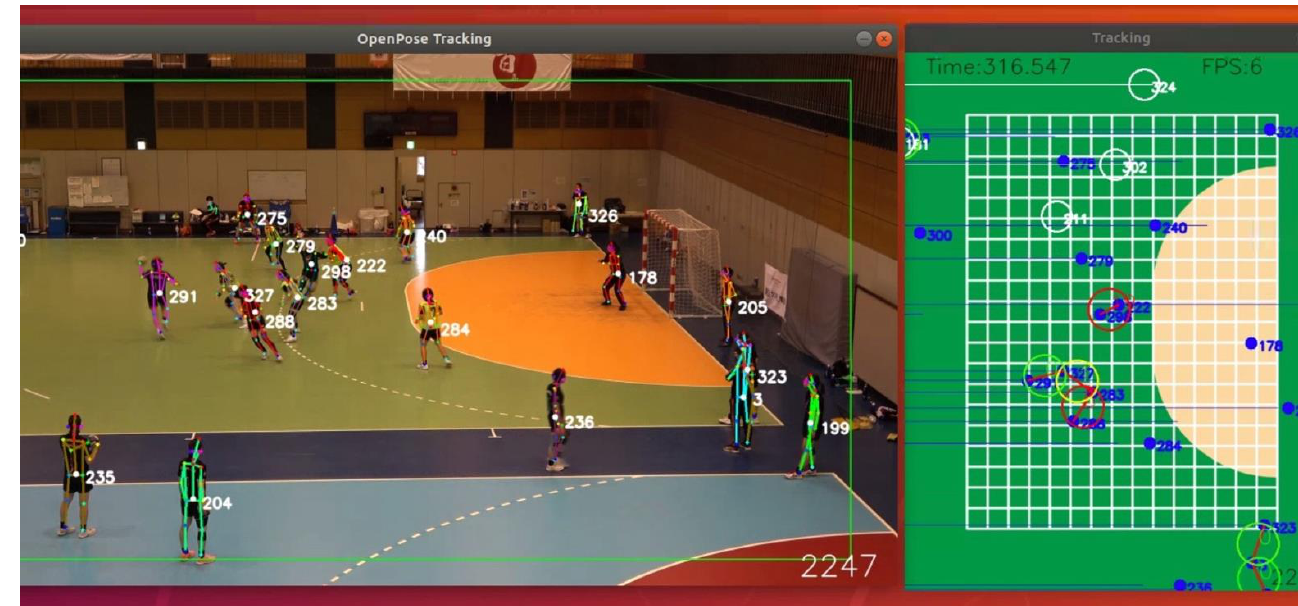
Figure 1. Real-time automated quantitative monitoring of social distancing with a motion image-based AI system, shown on Ubuntu 18.04.5 LST. This system identified participant positions using a function on OpenPose [17]. The distance between the players was calibrated based on known court geometry.